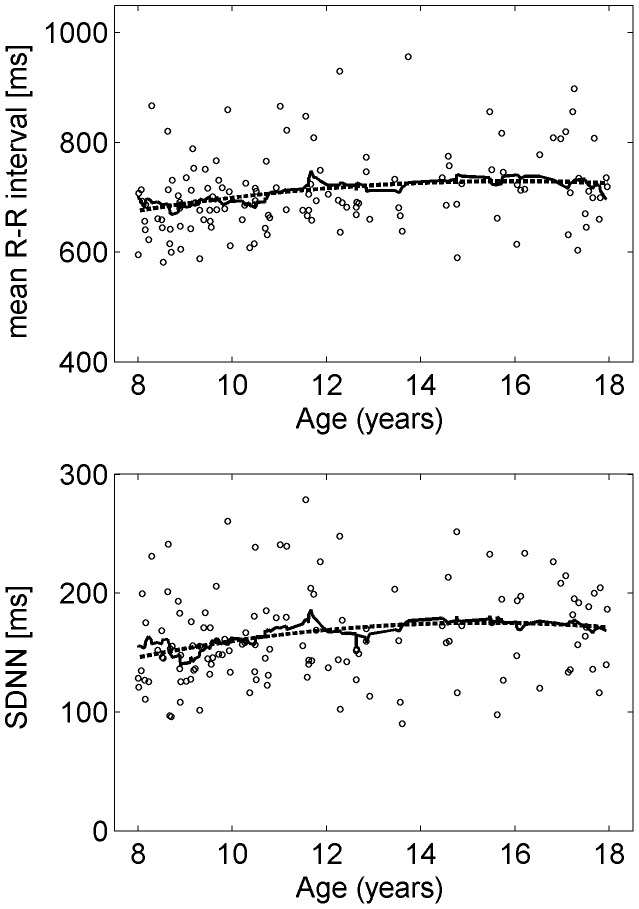
Examples of variations of HRV parameters with age.Age-related variations of the average RR interval (top) and the standard deviation of the distance between normal-to-normal heartbeats (bottom). The lines denote a polynomial fit of order 2 (dashed line) and the moving average (full line).